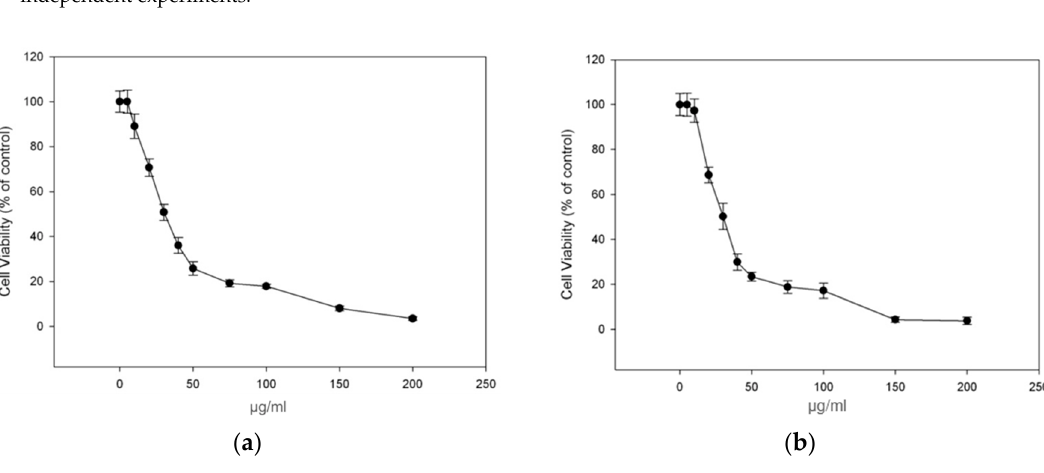
Figure 3. Propolis extracts protect HaCaT cells from UVB-induced DNA damage. Cells were pre- treated for 2 h with 20 μ g/mL of PR_1b ( a ) and PR_9b ( B ) and either irradiated with UVB 55mJ/cm 2 or left untreated (non-irradiated). Irradiated and non-irradiated cells were further incubated for 2 h in the presence or absence of propolis samples, recovered for 24 h in culture medium, and subjected to cell gel electrophoresis (comet) assay. The scoring was expressed in arbitrary units (AU) and was based on the extent of DNA damage under each experimental condition. The data presented are the mean ± SD of three independent experiments performed in duplicates. * p ≤ 0.05, significantly different from the irradiated cells. 3.3. Protection of HaCaT Cells by Propolis Extracts against UVB-Induced Oxidative Damage and Photoaging Phase-contrast microscopy and the trypan blue exclusion assay were utilized for determining the effect of PR_1b and PR_9b against UVB-induced cytotoxicity in HaCaT cells (Figure 4). As noted, UVB irradiation resulted in a significant reduction of cell viability accompanied by morphological